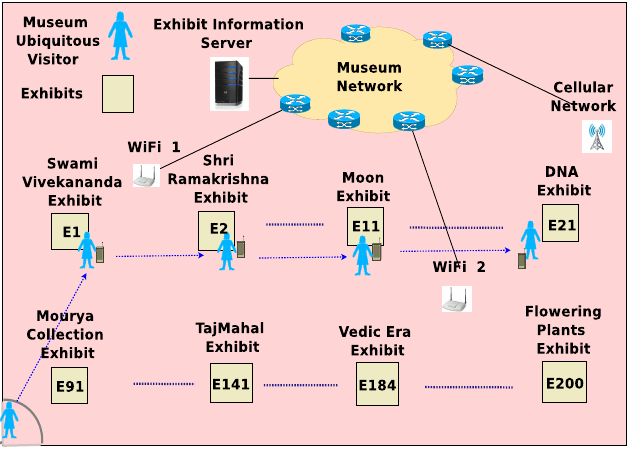
Figure 5. The Layout of Museum Environment